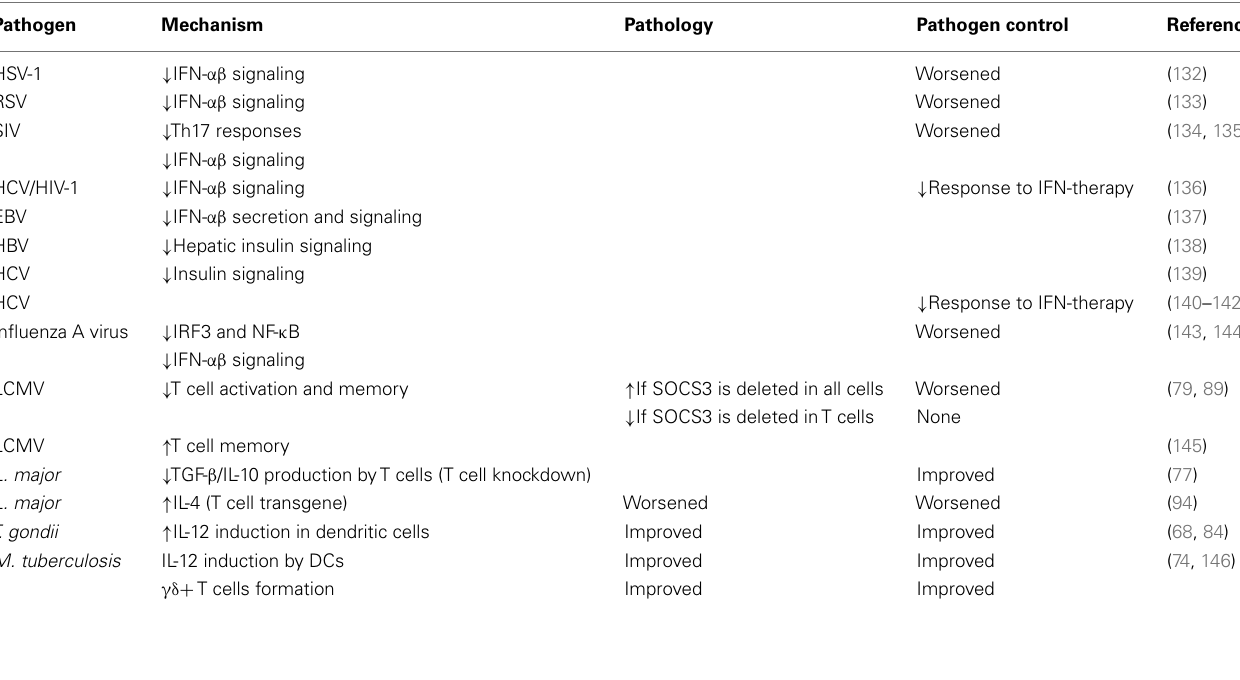
Table 3 | Role of SOCS3 in